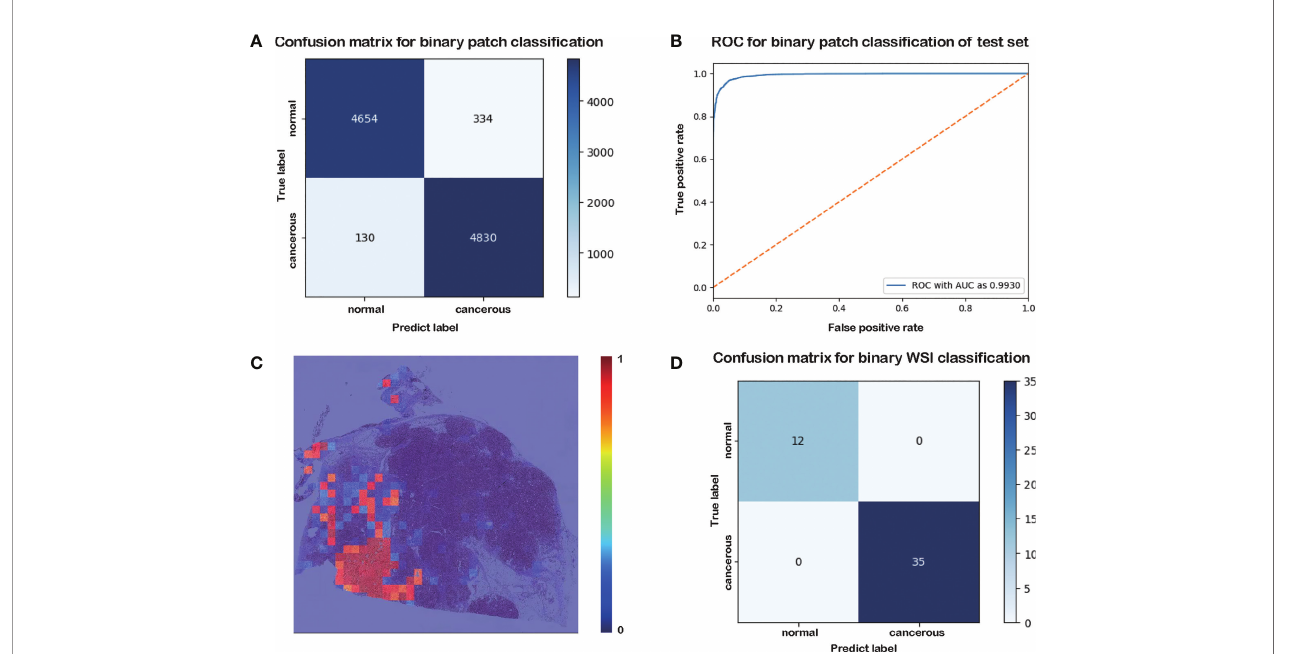
FIGURE 2 | Results of the patch-level classi fi cation for the test data. (A) Confusion matrix for binary patch classi fi cation. (B) ROC. (C) Heatmap of cancer probability generated by our trained classi fi er. (D) Confusion matrix for binary WSI classi fi cation.